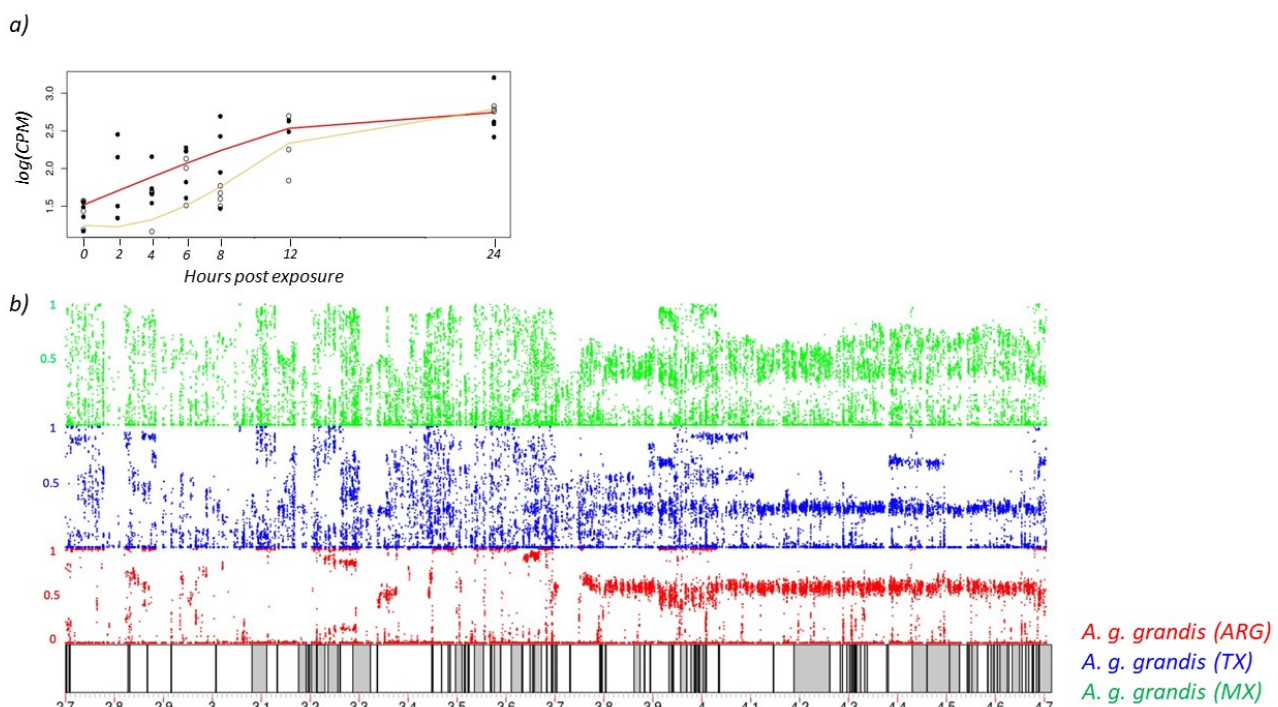
Figure 2. ( a ) Acetylcholinesterase (AChE) gene expression (log transformed counts per million) in the boll weevil over 24 h. The yellow line indicates the transcriptomic response to the low concentration treatment and the red line indicates the high concentration treatment. Closed circles represent gene expression values for individual weevils exposed to the high concentration of malathion, and open circles are weevils exposed to the low concentration. ( b ) Schematic of the 4 MB region on Chromosome 8 flanking the AChE gene. Gray bars indicate 88 annotated genes. The AChE gene is in the center. Colored dots represent 22,221 SNPs among the three weevil populations. Anthonomus grandis grandis population from Argentina is shown in red, Texas population in blue, and Mexico population in green. The y ‐ axis for each of the colored sections is minor allele frequency where a frequency of one indicates fixation of the minor allele.